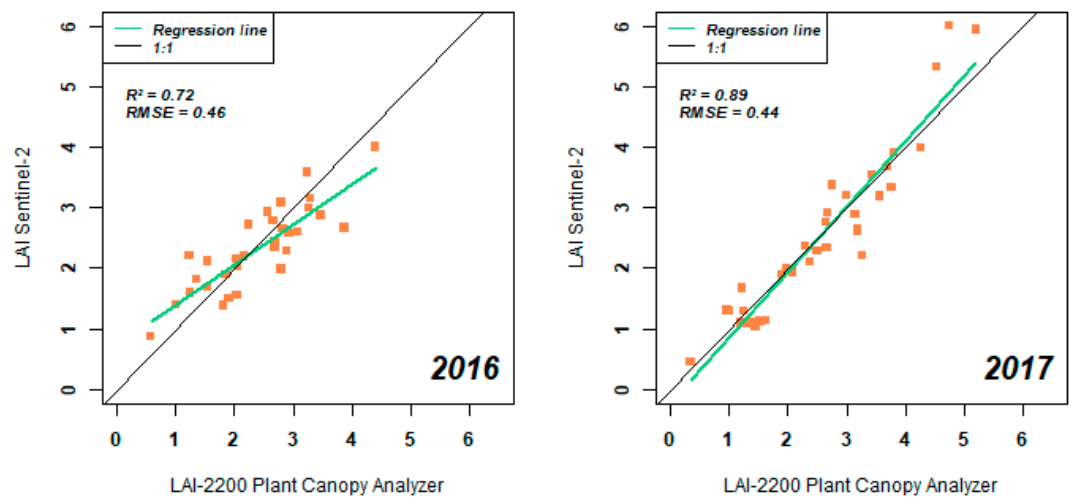
Figure 3. Scatterplot between ground and satellite LAI measurement for Marchfeld in 2016 (n = 31, Feb.–May) and in 2017 (n = 35, Feb.–June) for winter cereals.